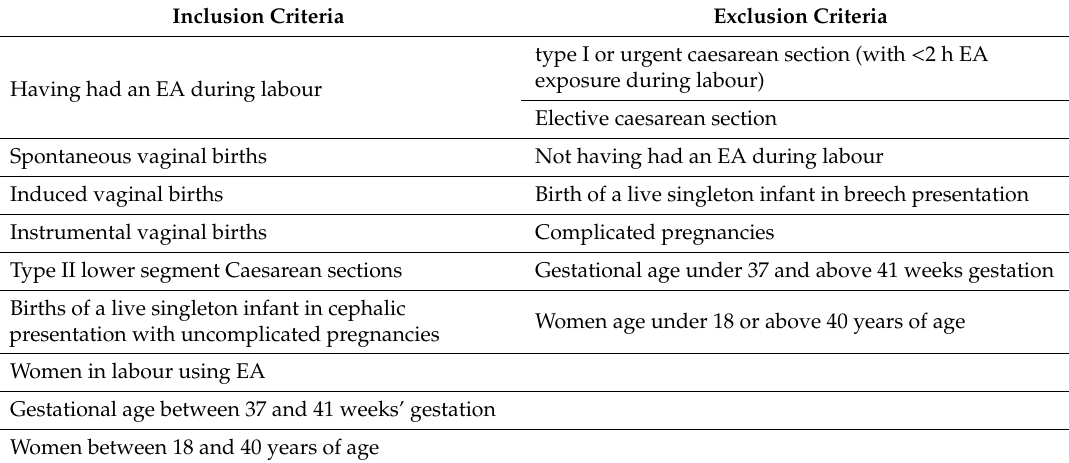
Table 1. The inclusion / exclusion study